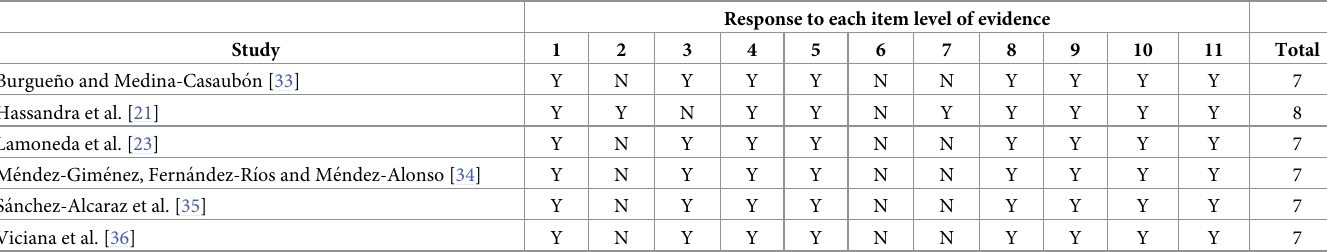
Table 1. Risk of bias according to the PEDro